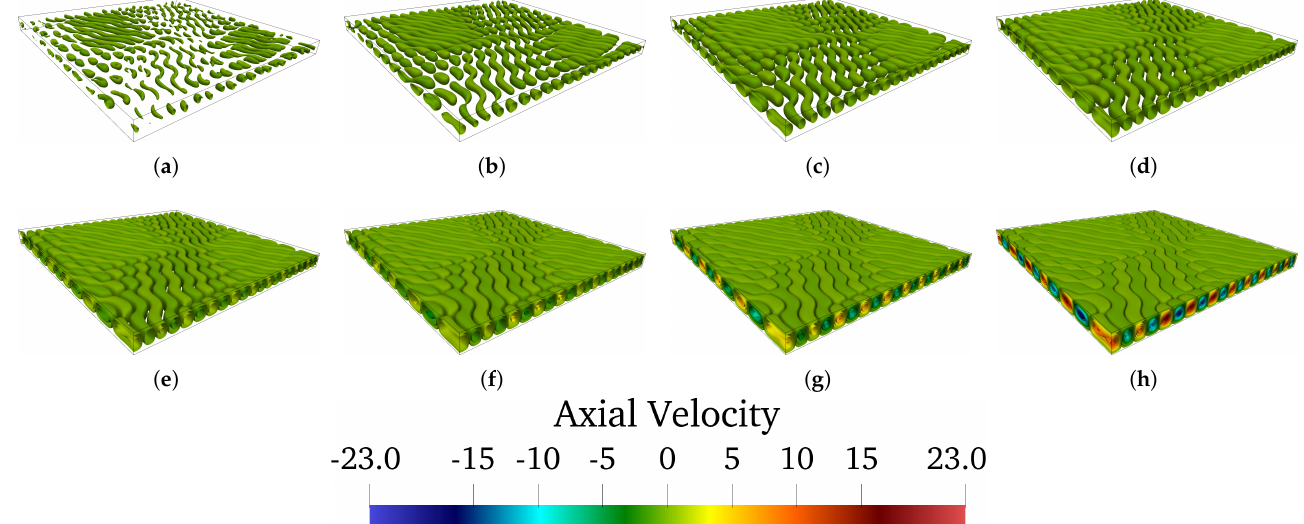
Figure 5. Thermovibrational convection in a layer of FENE-CR fluid delimited by differentially heated solid walls (snapshots of the isosurfaces of the vertical component of velocity evenly distributed over the interval I 2 ). Pr g = 8, Ω = 25, Ra ω = 4000, ξ = 0.5, ϑ = 0.1, sinusoidal